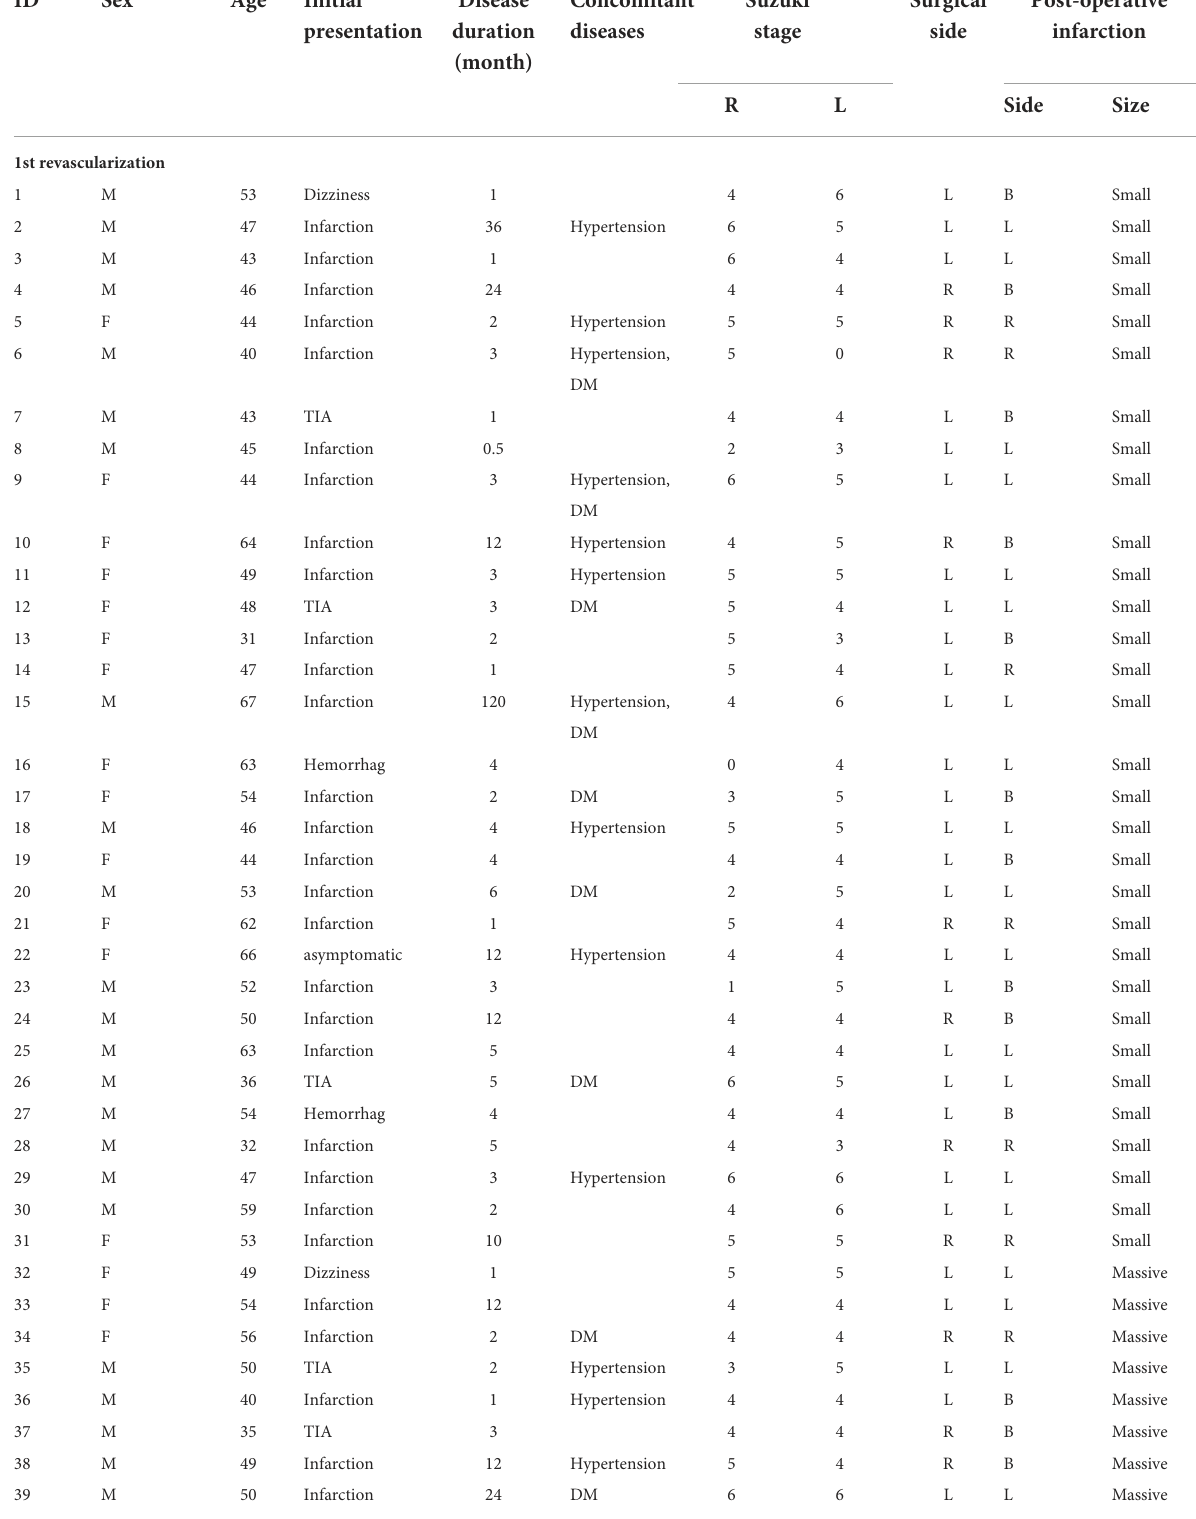
TABLE 2 Details of patients with postoperative infarction